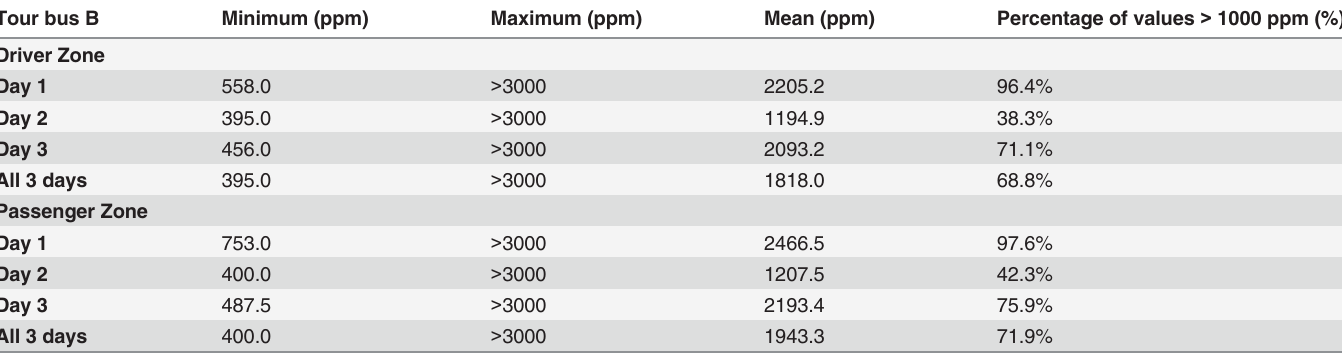
Table 2. Results of CO 2 concentration monitored in tour bus B under real-time traffic